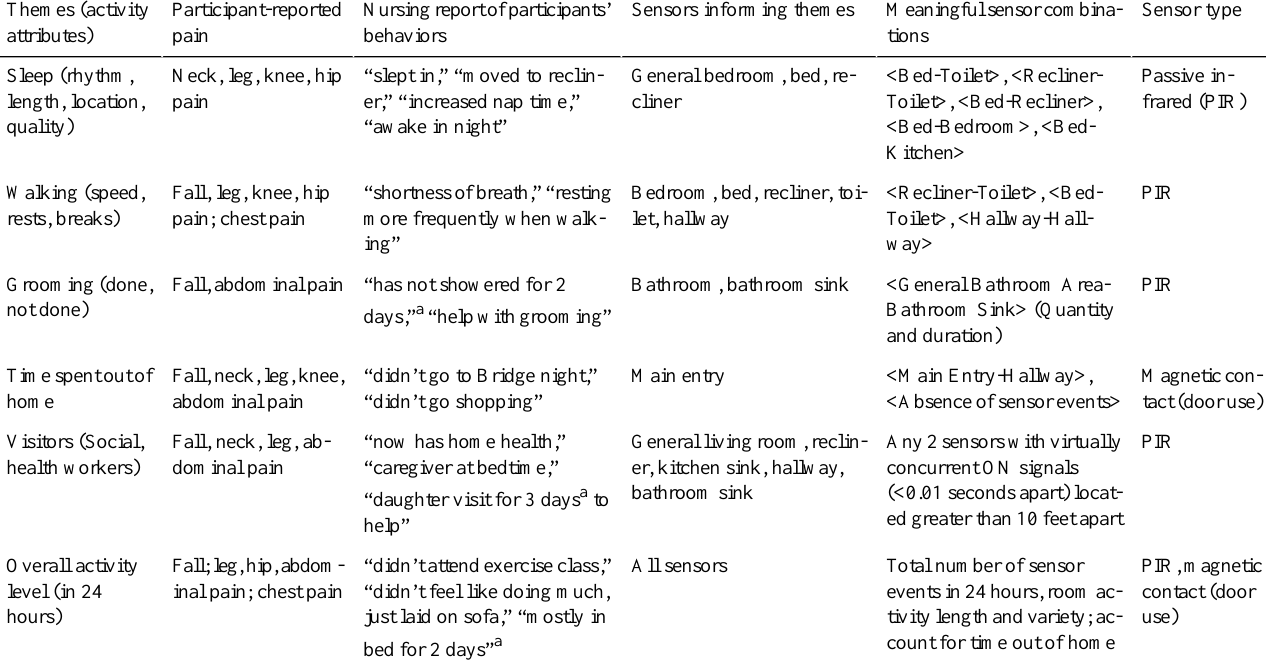
Table 2. Themes representing pain-related